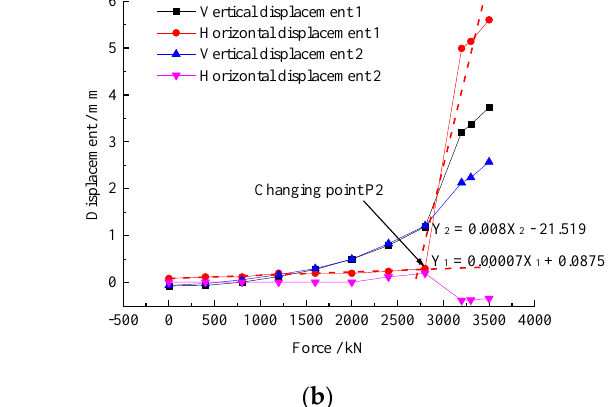
Figure 12. Position of the sensors.